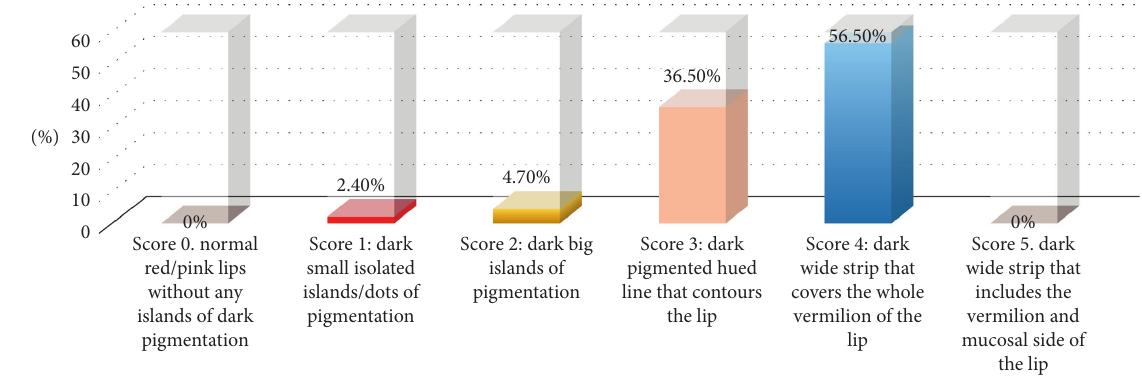
Figure 4: Cases distribution according to the melanin pigmentation Table 1: Descriptive analysis of the current study using Er,Cr :YSGG laser.